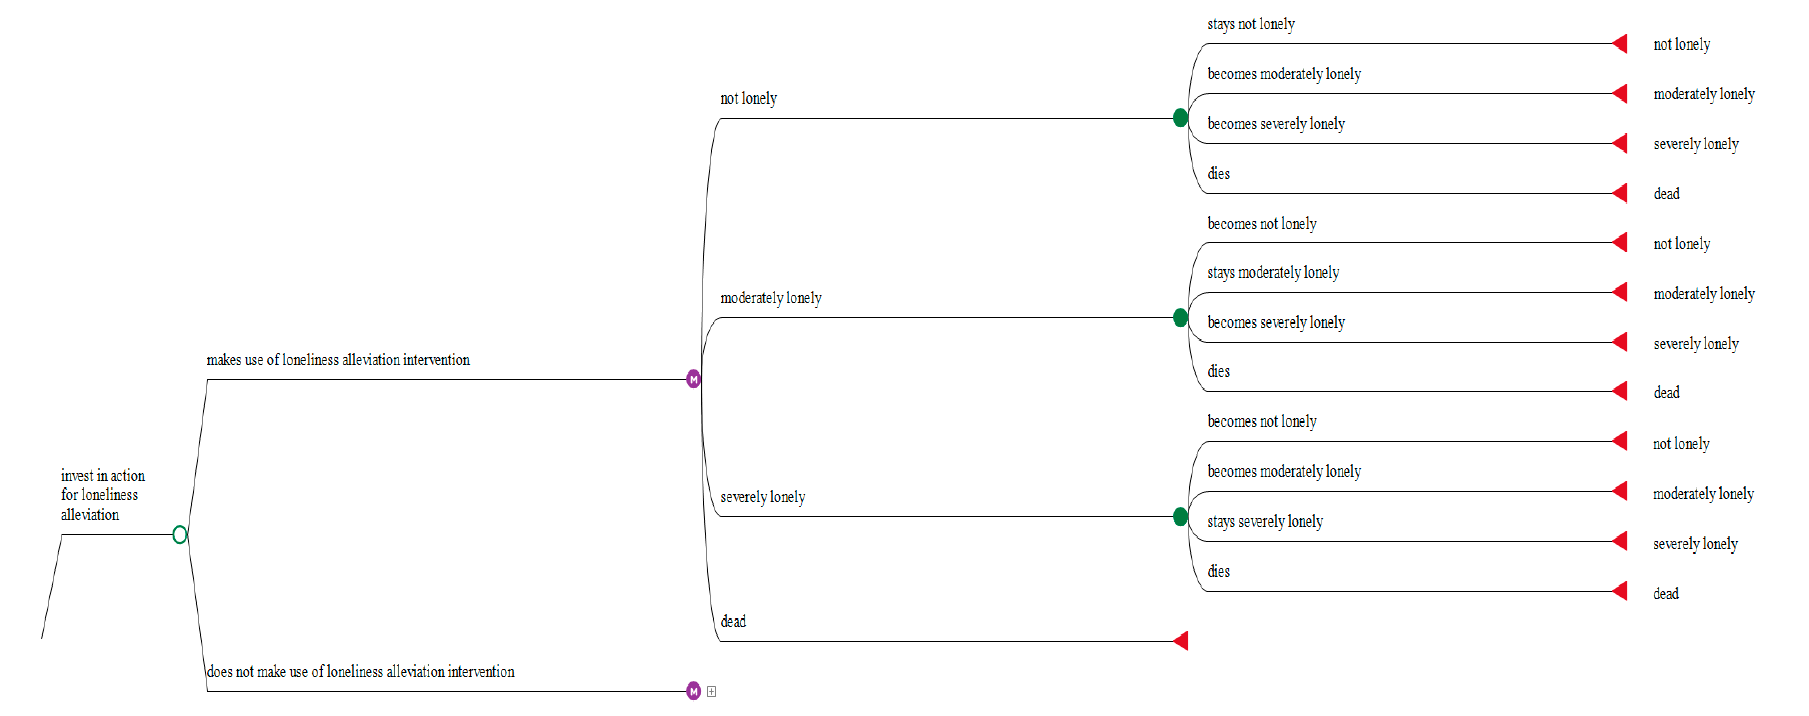
Figure 1. Excerpt of the Markov model.